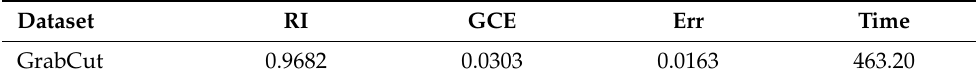
Table 4. Performance measures for the proposed procedure coupled with a pre-processing procedure based on machine learning technique. The performance of the RawaCs algorithm improves wrt to each evaluation index: the sole drawback is the high computational time required. The computational time is measured in